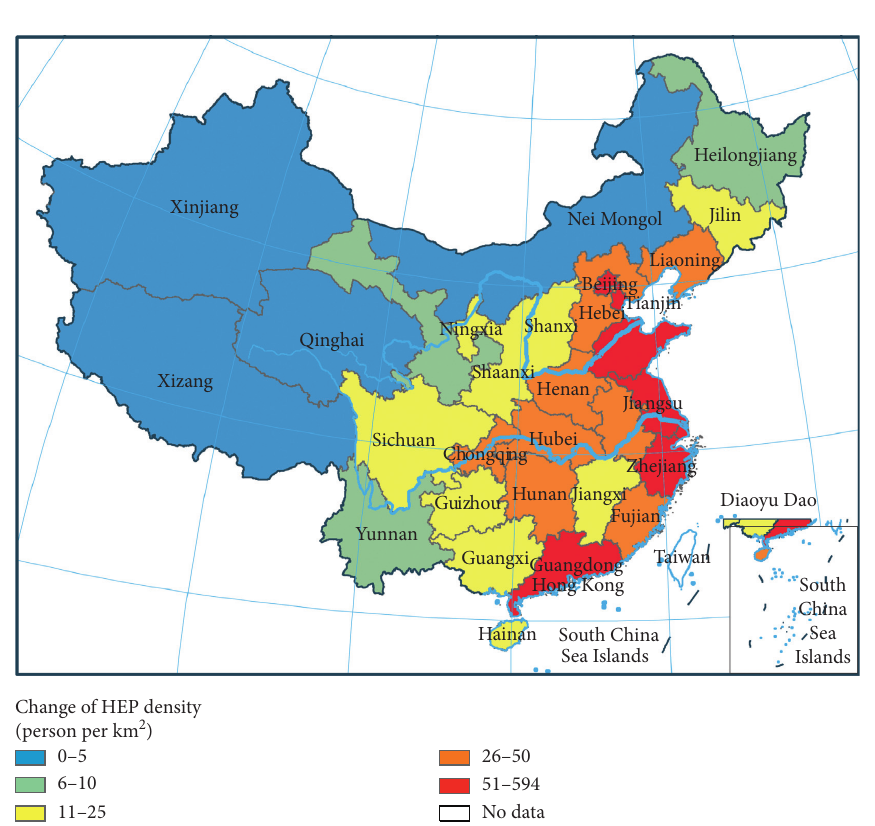
Figure 3: Change of HEP density from 2000 to